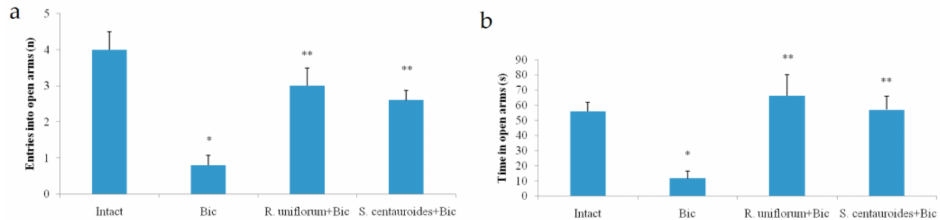
Figure 3. Entries into open arms ( a ) and time in open arms ( b ) in elevated plus maze test after R. uniflorum and S. centauroides extracts application against bicuculline (Bic) introduction. Data represent as mean ± S.E.M. *— p < 0.05 vs. intact group; **— p < 0.05 vs. Bic